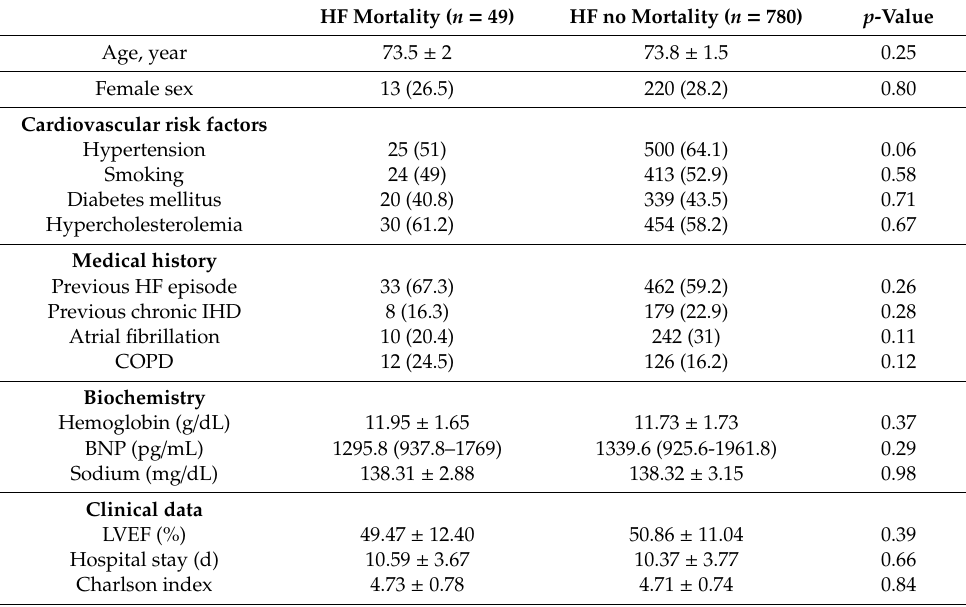
Table 1. Baseline characteristics of the study population as a function of in-hospital